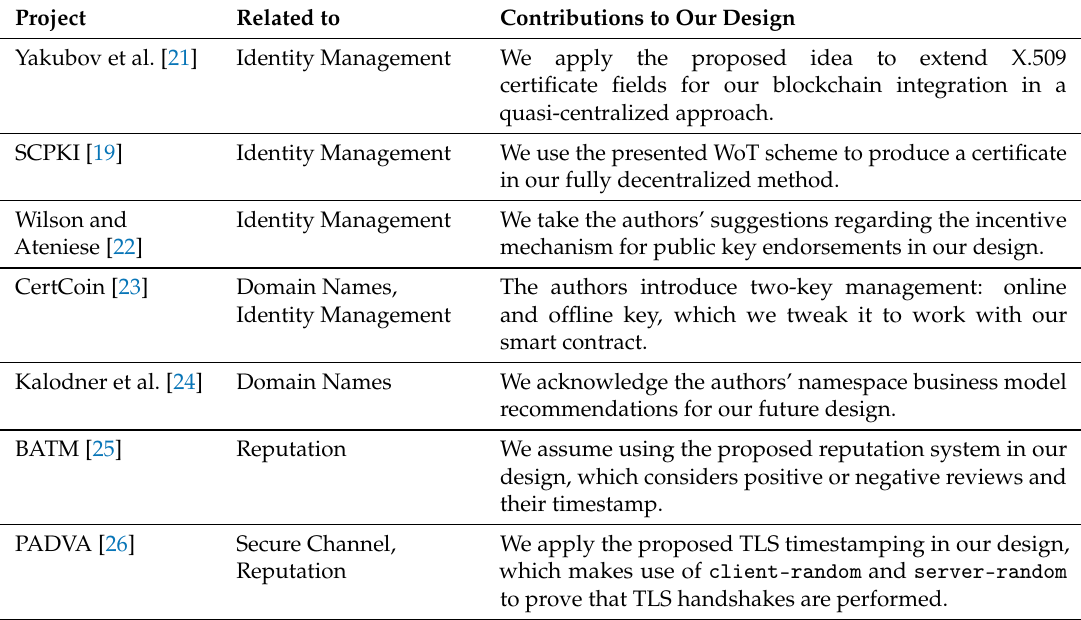
Table 2. The list of related works serving as building blocks for our data in transit